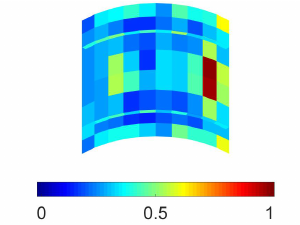
Figure 7. Stiffened fuselage section problem, Case (1), macroscale analysis: contour plot of the objective function ψ M